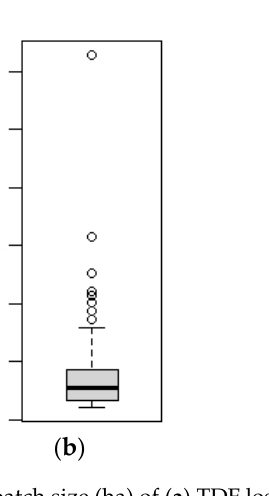
( b ) Figure 5. Probability of TDF loss ( a ) and TDF gain ( b ) predicted with the best models. ( a ) Probability of TDF loss predicted with slope and distance to roads. ( b ) Probability of TDF gain predicted with slope and distance to roads. The potential areas of TDF loss and gain were predicted by reclassifying the proba- bility maps with a threshold of 0.5 (Table A7). Overall, 43.1% of the total TDF area was predicted as TDF loss and 35.4% as TDF gain (Table A7), showing that TDF loss was a dominant process in the study area. This pattern coincides with the area estimates for loss and gain, although their CIs overlapped (Table 3). 3.6. Comparison of the Verified Forest Loss and Gain The statistics for TDF loss showed a median size of 7.2 ha, an average of 14.3 ha, a